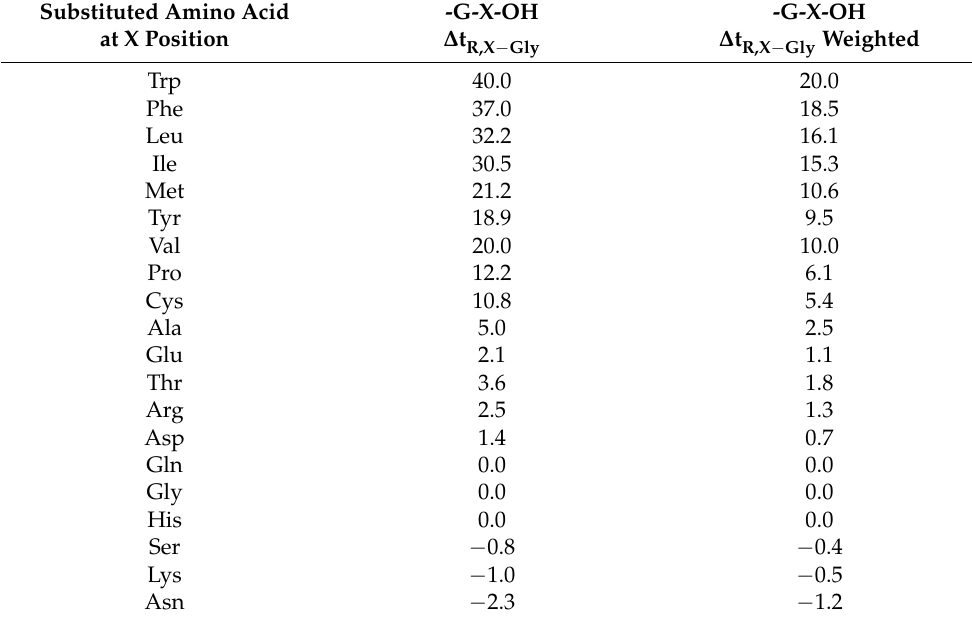
Table 17. The weighed retention coefficients of peptide 1 [31]. Substituted Amino Acid at X